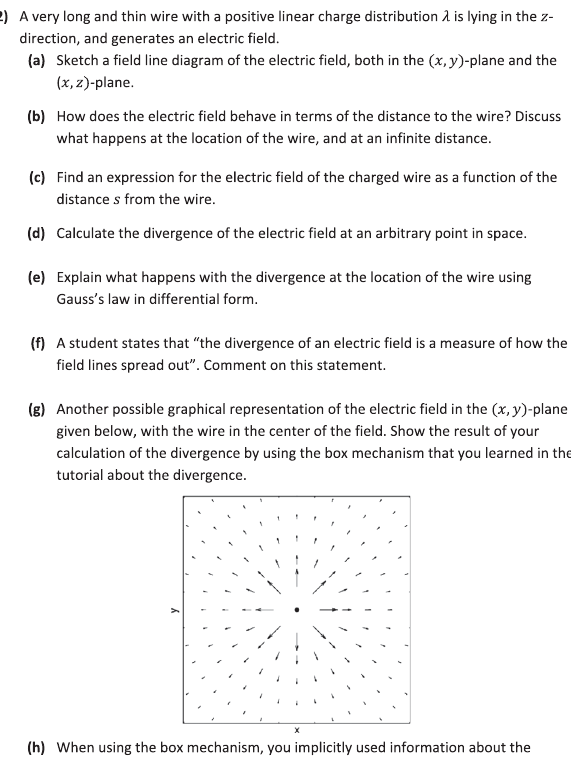
FIG. 3. Excerpt of a worksheet used in the Gauss ’ s law tutorial in differential form. In the original format, some blank space was left after every subquestion for the students to formulate their responses.